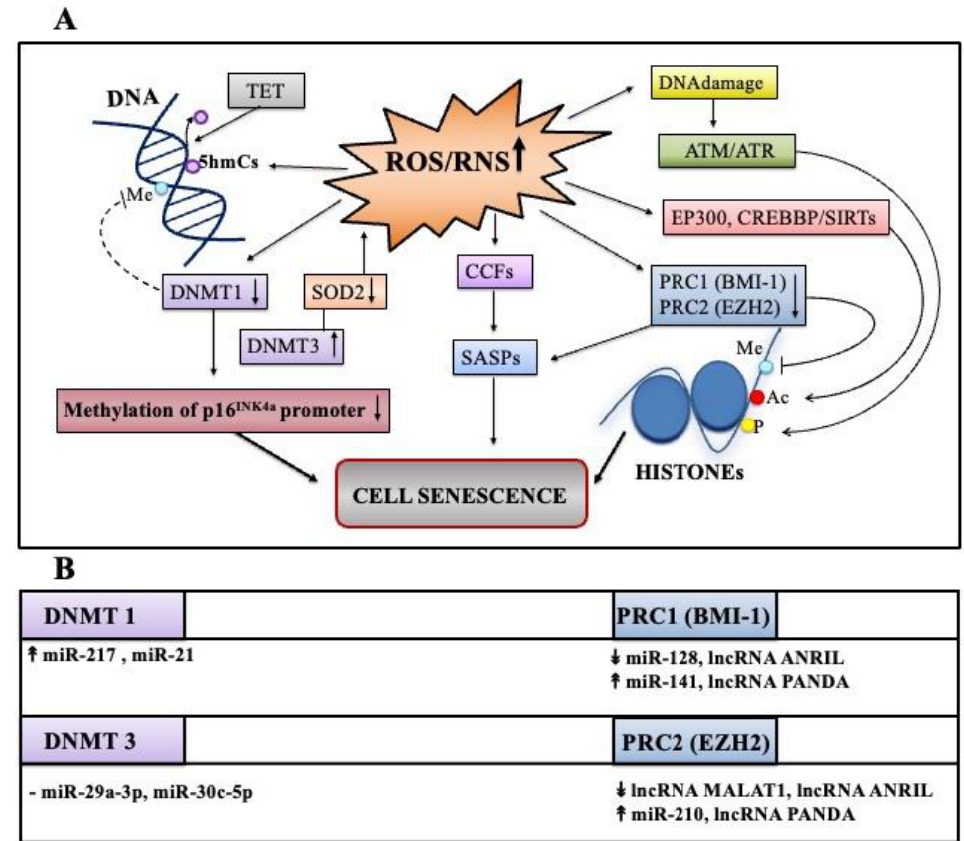
Figure 4. Summary of major epigenetic landscape through ROS/RNS. ( A ) ROS attack cytosines methylated at C5 (5mC), which become 5-hydroxymethylcytosines (5hmCs). These latter can be further oxidized by TET enzymes prompting local DNA demethylation. Increased activity of DNMT3 reduces SOD2 expression that provokes ROS elevation, and consequently, senescence. On the contrary, ROS/RNS reduce the expression of DNMT1 with consequent demethylation of p16 INK4a promoter and increased expression of p16. ROS/RNS can directly generate DNA damages, which are engaged by the kinase ATM/ATR that phosphorylates the serine 139 of the histone H2AX variant. ROS/RNS can reshape histone modifications (such as acetylation and methylation) by altering enzymatic reactions of the histone acetylases/deacetylases, such as EP300 or CREBBP/SIRTs and/or histone methylases/demethylases, such as EZH2, BMI-1 of the PRC complexes. Mitochondrial ROS induce the release of cytoplasmic chromatin fragments involved in SASP stimulation. ( B ) Overview of non-coding RNAs deregulated in senescence that can impact epigenetic landscape through ROS/RNS signaling pathways. Up and down arrows indicate ncRNA levels that have been found as increased or decreased, respectively in various models of oxidative stress-induced senescence.